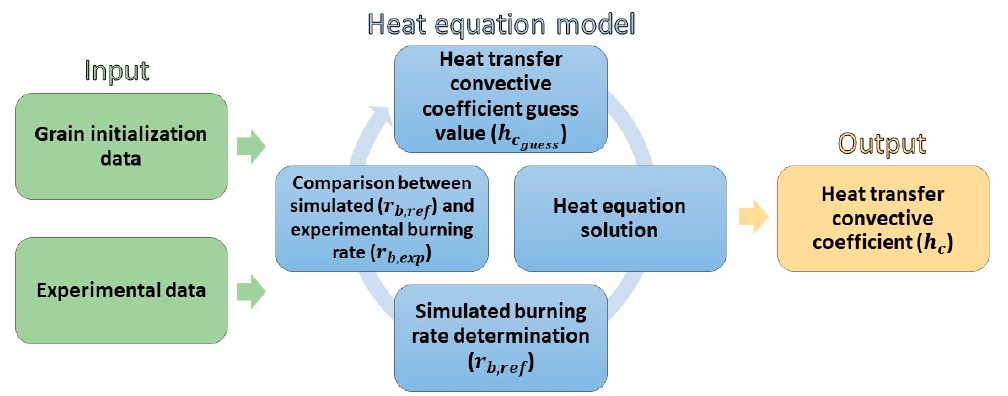
Figure 9. Heat equation model flowchart.